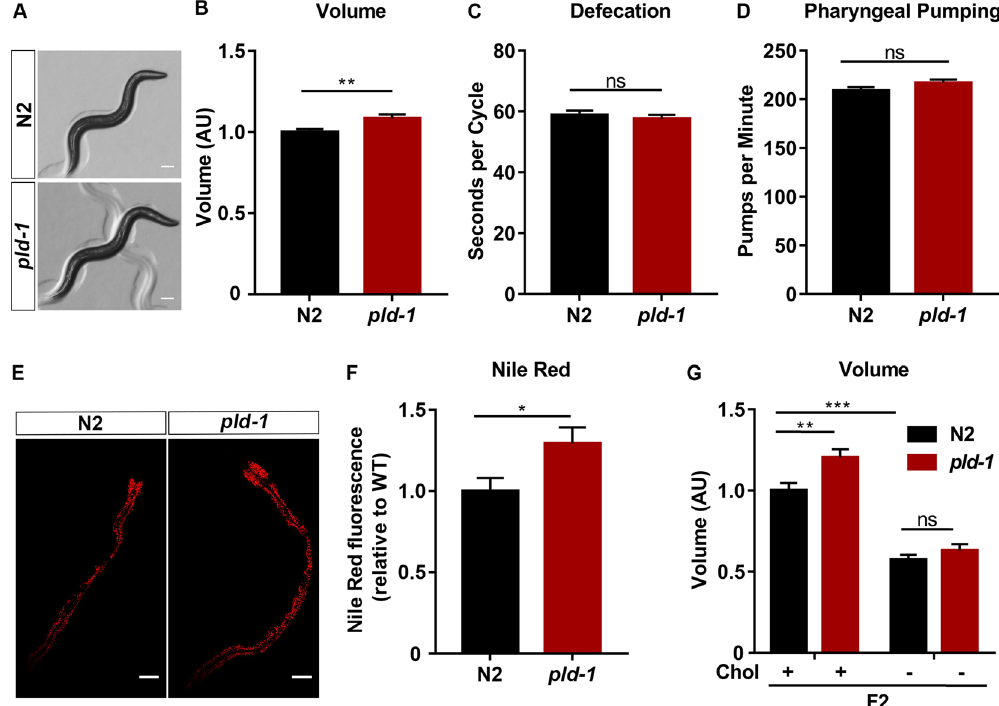
Figure 3. PLD modulates C . elegans volume. ( A , B ) pld-1 worms have an increase in body volume. Representative photos ( A ) and graphic analysis of volume ( B ) of N2 and pld-1 animals at day 3 after egg laying. The scale bar represents 100 µ m. ( B ) 40 animals were analyzed per strain in 3 independent experiments. ( C , D ) pld-1 worms have no alterations in physiological parameters, namely ( C ) defecation cycle length and ( D ) pharyngeal pumping rate (n = 3, 10 animals per assay). ( E , F ) pld-1 worms have changes in lipid balance. Nile Red staining representative photos ( E ) and quantification of Nile Red fluorescence of N2 and pld-1 worms at day three post-hatching. Photographs were taken at 60 × magnification. Scale bar represents 100 µ m. ( G ) pld-1 and N2 animals present similar volumes upon cholesterol depletion. Volume analysis of F2 generation (N2 and pld-1 ) animals at 72 h after egg laying, in the presence or absence of cholesterol. The data results from the analysis of 45 worms per strain in